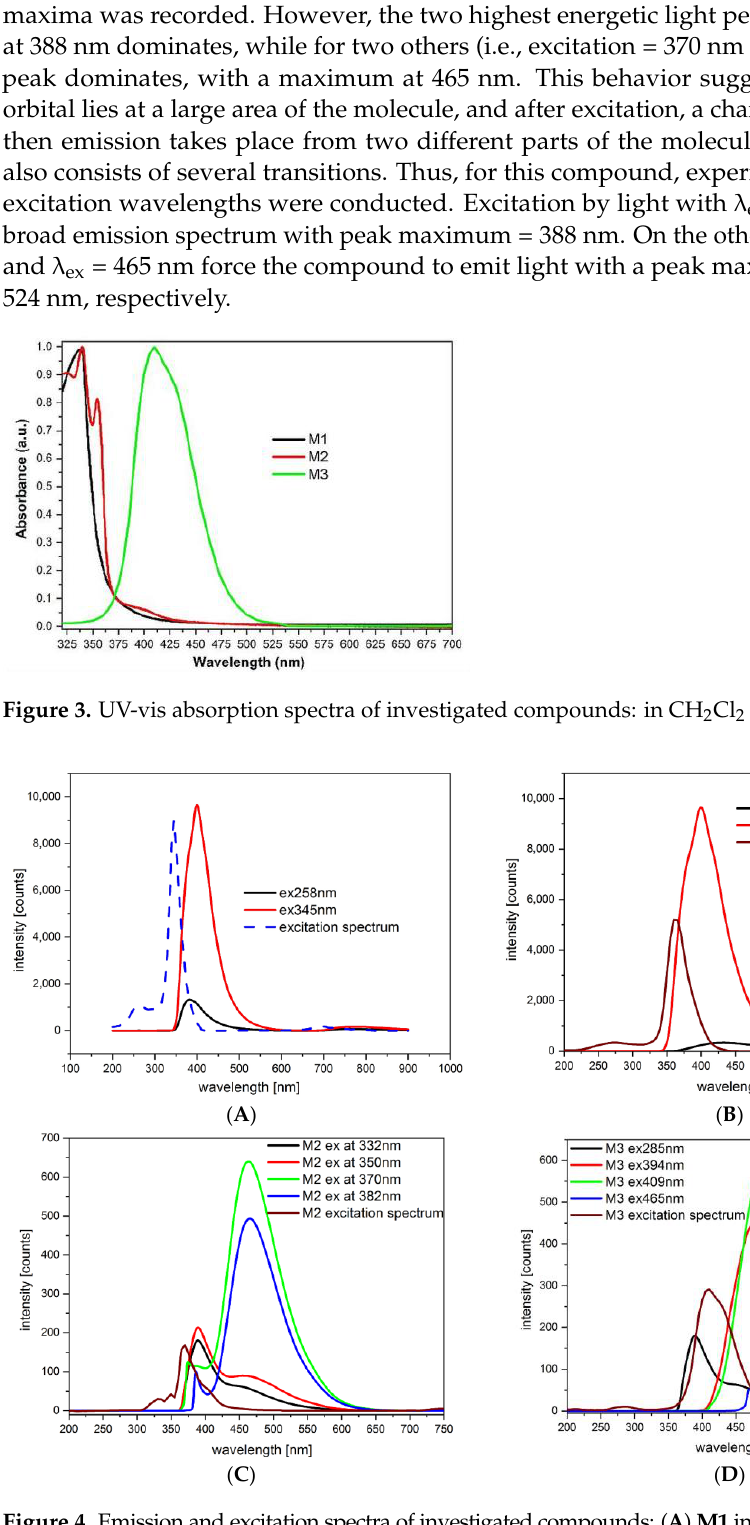
Figure 4. Emission and excitation spectra of investigated compounds: ( A ) M1 in MeCN (c = 1 × 10 −5 M); ( B ) M1 in CH 2 Cl 2 (c = 1 × 10 −5 M); ( C ) M2 in CH 2 Cl 2 (c = 1 × 10 −5 M); ( D ) M3 in CH 2 Cl 2 (c = 1 × 10 −5 M).